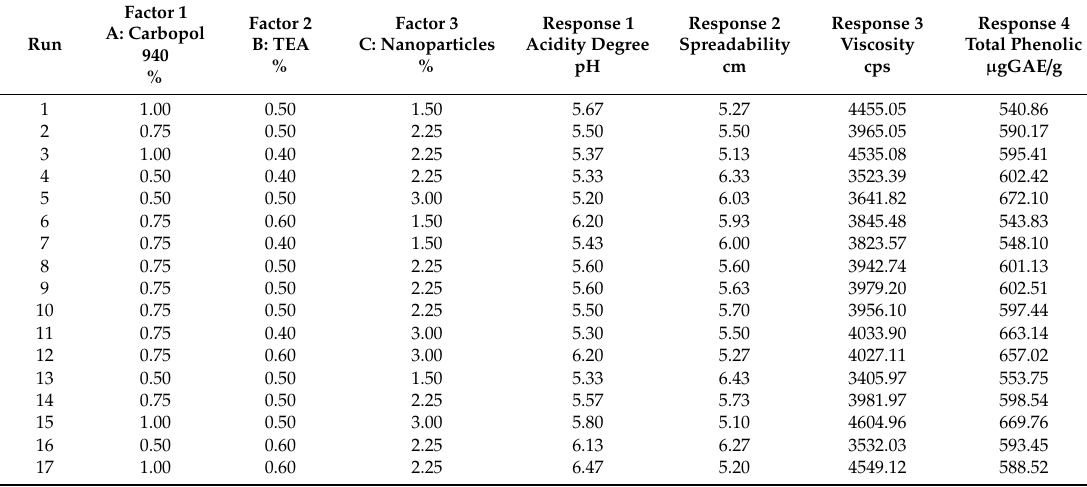
Table 2. Formulation design and dan characterization results of arabica co ff ee ground nanoparticles gel formulation with three factors (x) and three